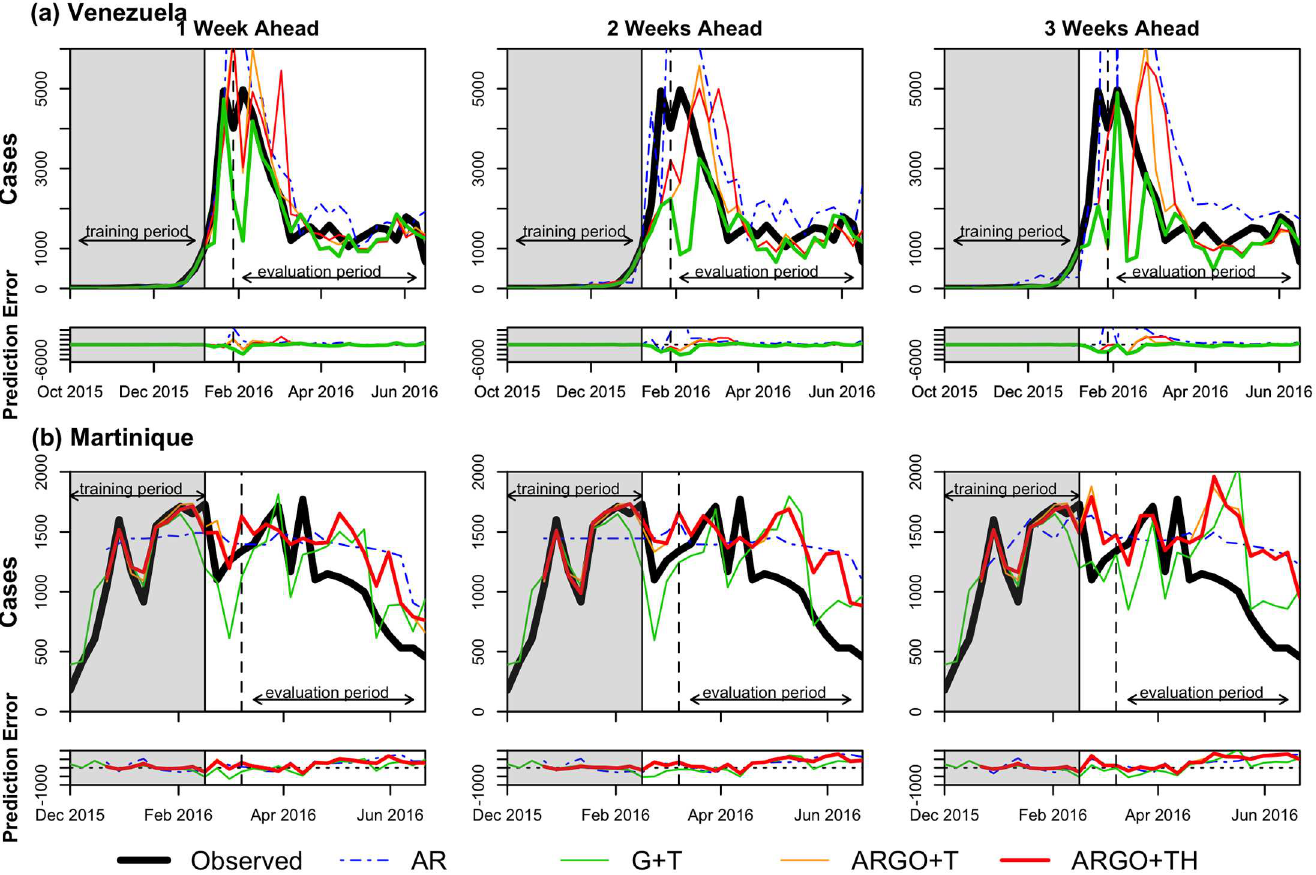
Fig 2. Prediction results for (a) Venezuela and (b) Martinique. In each country, the weekly estimationsof AR (dotted blue), G+T (green), ARGO+T (orange),and ARGO+TH (red) models are comparedto the official case counts (black). Models includeTwitter data where available(Venezuela). The best model performance (lowest relative RMSE) in each time series by country is shown as a